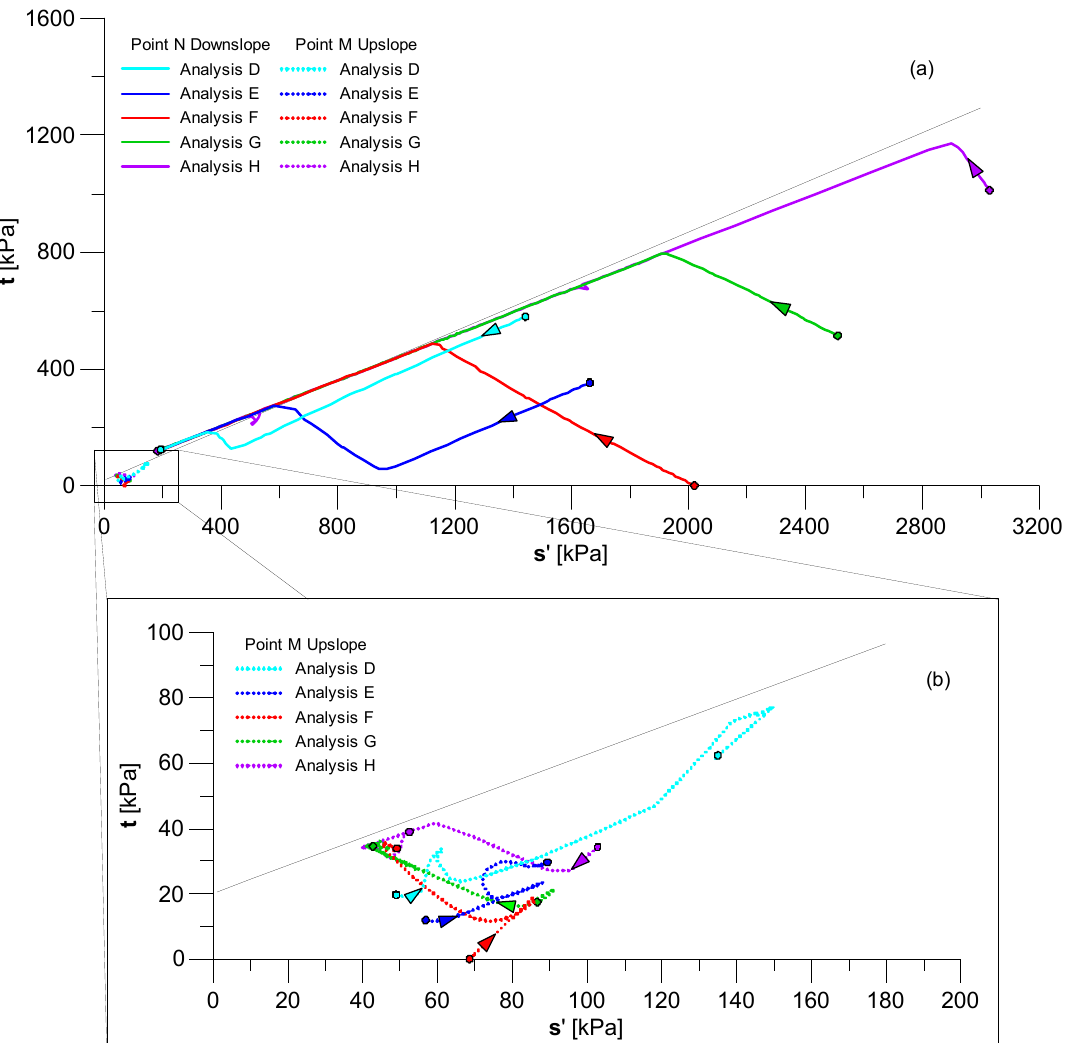
Figure 10. Stress paths during the excavation phases at the stress points M and N ( a ); zoom of the stress